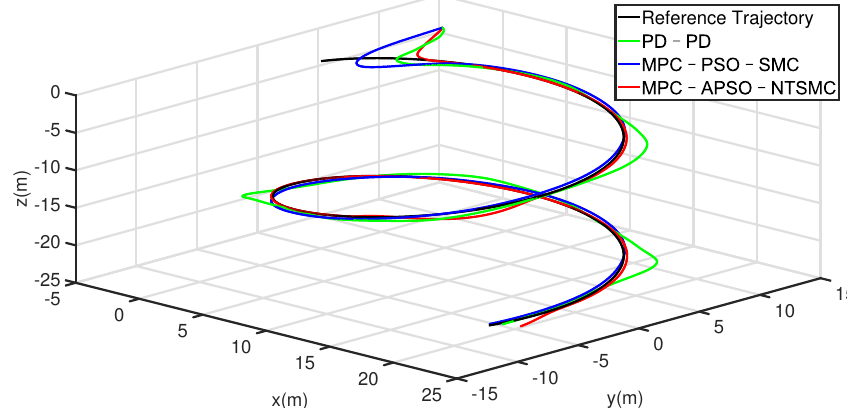
Figure 17. AUV spiral trajectory tracking with wave and current disturbance for Case 1.